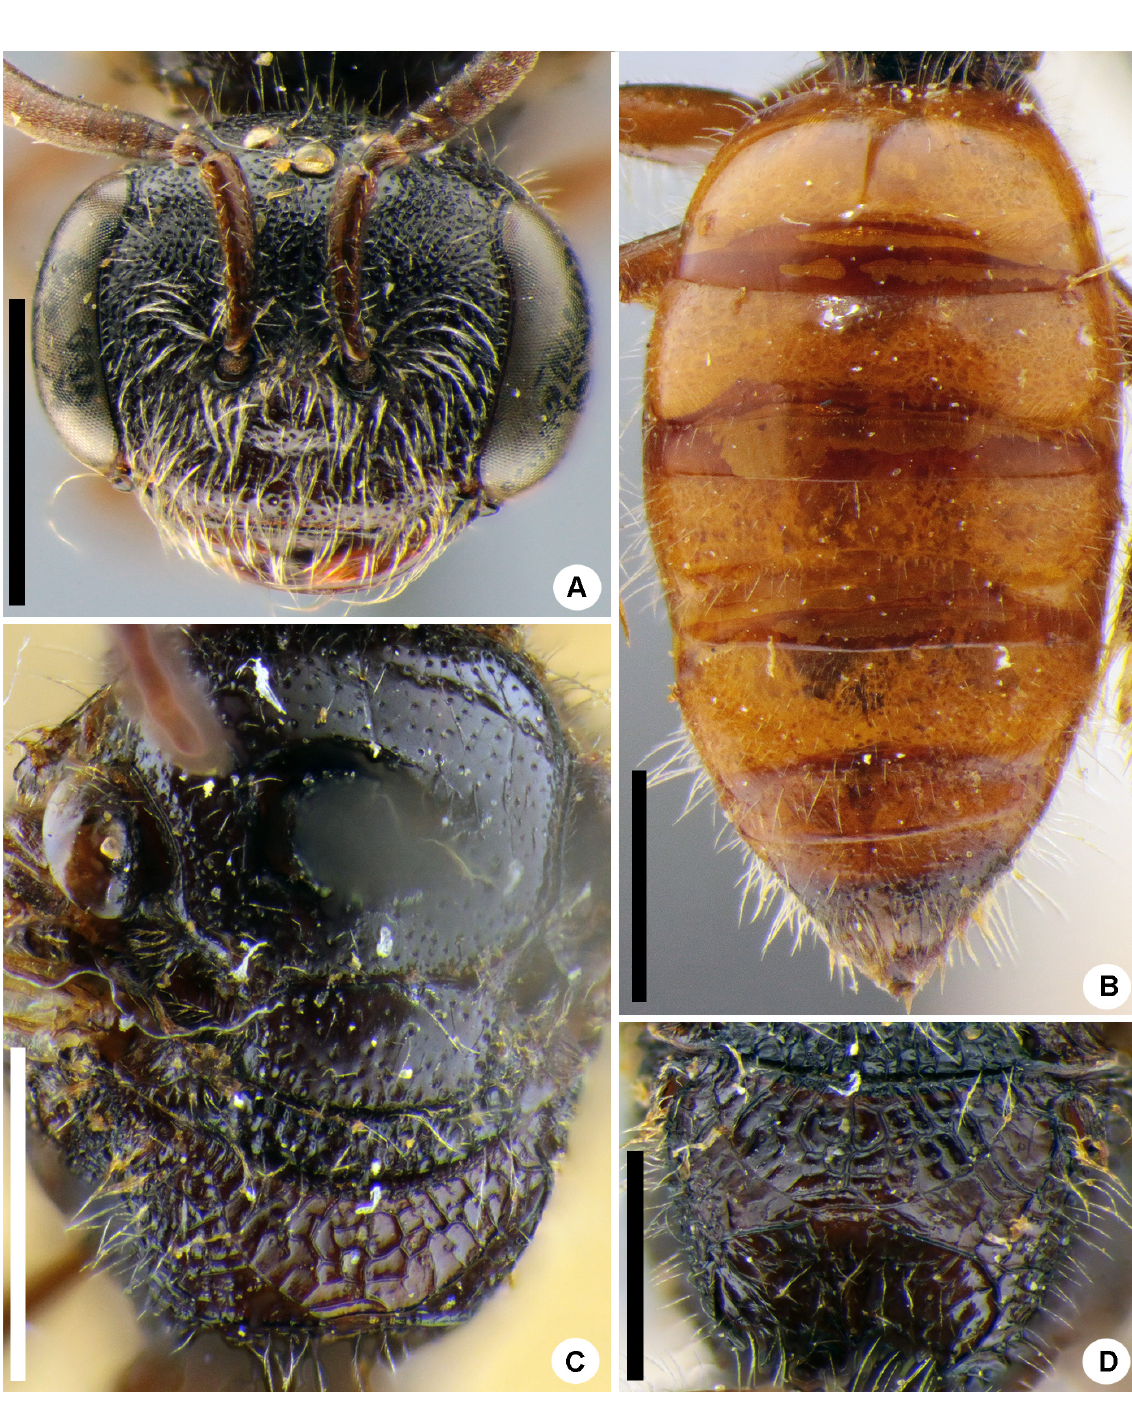
Fig. 20. Sphecodes tantalus Nurse, 1903. Syntype, ♀ (ZMHB). A . Head in frontal view. B . Metasoma in dorsal view. C . Mesoscutum and propodeum in dorsal view. D . Propodeum in dorsal view. Scale bars: A–C = 1 mm; D = 0.5